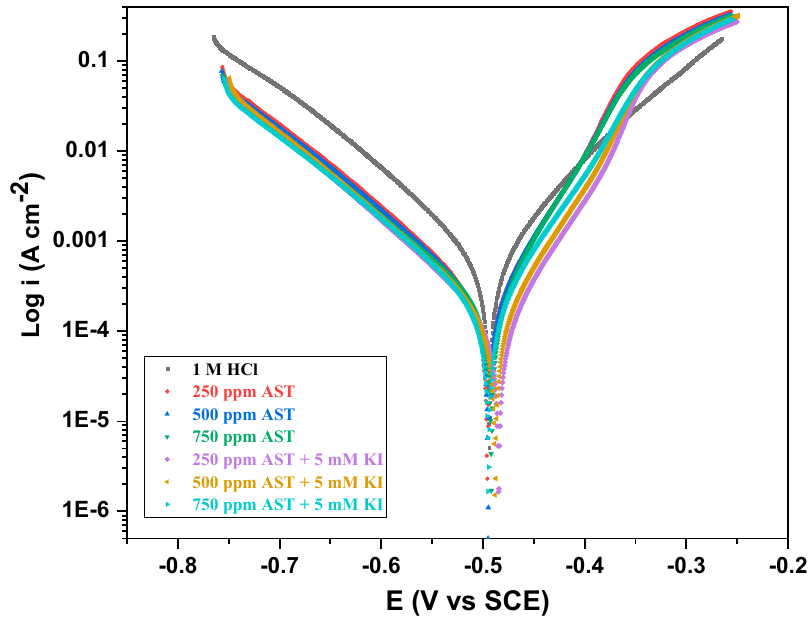
Figure 5. Potentiodynamic polarization (Tafel) curves for C1018 carbon steel corrosion in 1 M HCl with various concentrations of AST inhibitors and AST + KI.